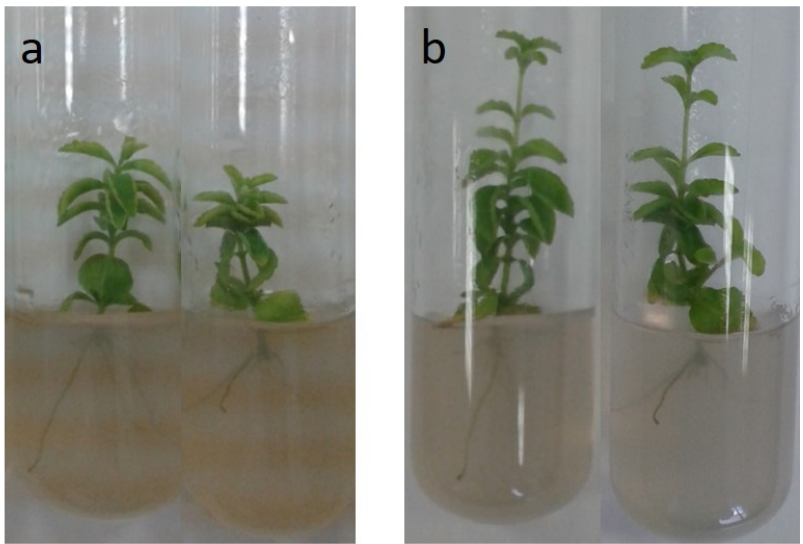
Figure 5. Morphological changes of S. rebaudiana microshoots ( a ) after 20 days being cultured on MS media without PGRs under red-blue LEDs, and ( b ) after 5 days being returned to fluorescent white lamps.